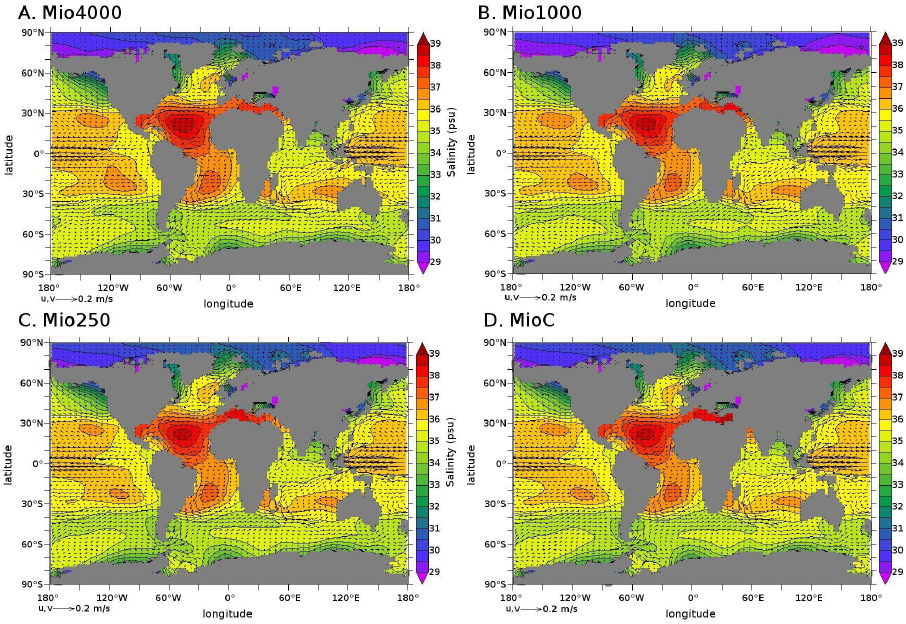
Fig. 3. Simulated annual salinity (psu) averaged over the top 100m of the water column. Vectors indicate annual surface horizontal flow (ms − 1 ). (A) Mio4000, (B) Mio1000, (C) Mio250 and (D)